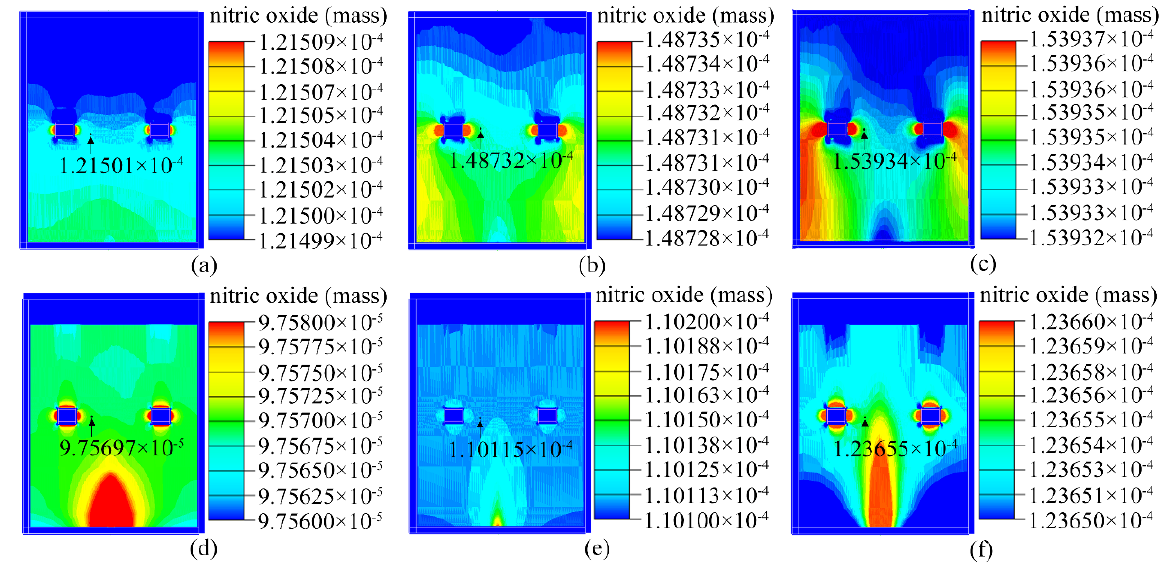
Figure 7. Mass of NO in the closed box. Type I electronic nose at ( a ) 200 SCCM, ( b ) 600 SCCM, and ( c ) 1000 SCCM. Type II electronic nose at ( d ) 200 SCCM, ( e ) 600 SCCM, and ( f ) 1000 SCCM.